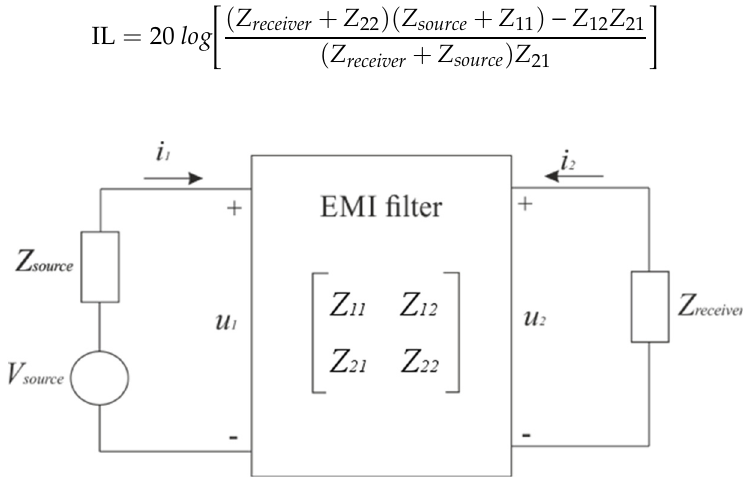
Figure 2. Electromagnetic interference (EMI) filter representation by its impedance matrix.